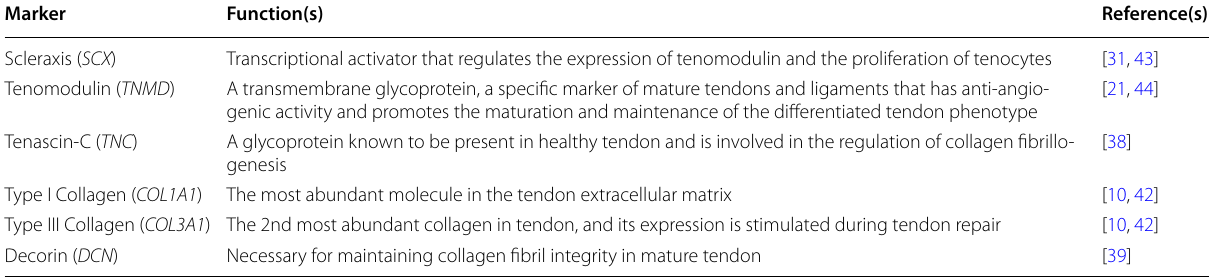
Table 1 Markers of tenocyte phenotype. Tenocyte phenotypic markers, their associated functions, and references are provided Marker